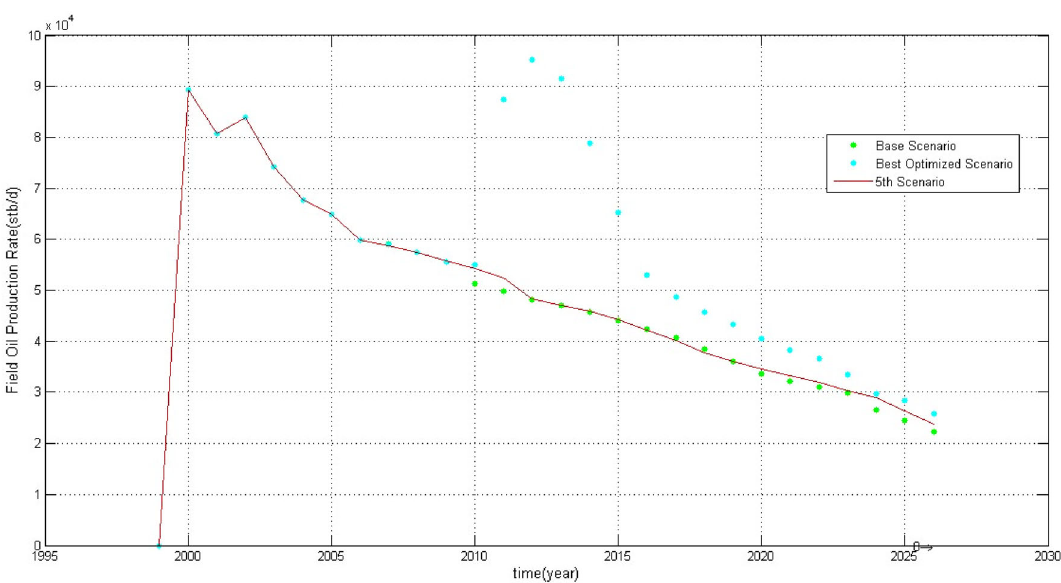
Fig. 11 Field production rate of fifth